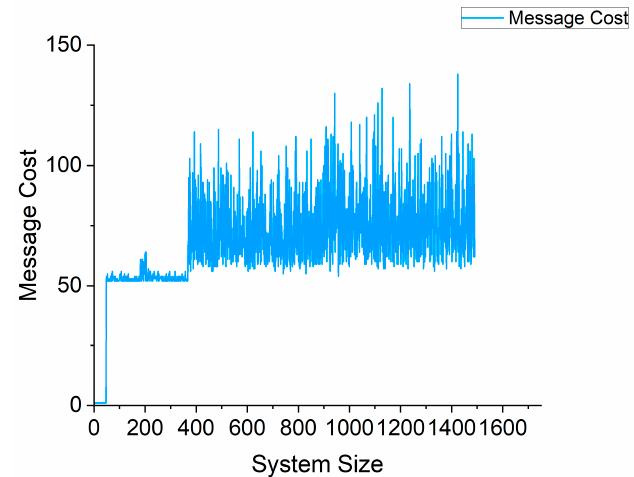
Figure 11. Node-joining overhead at different system